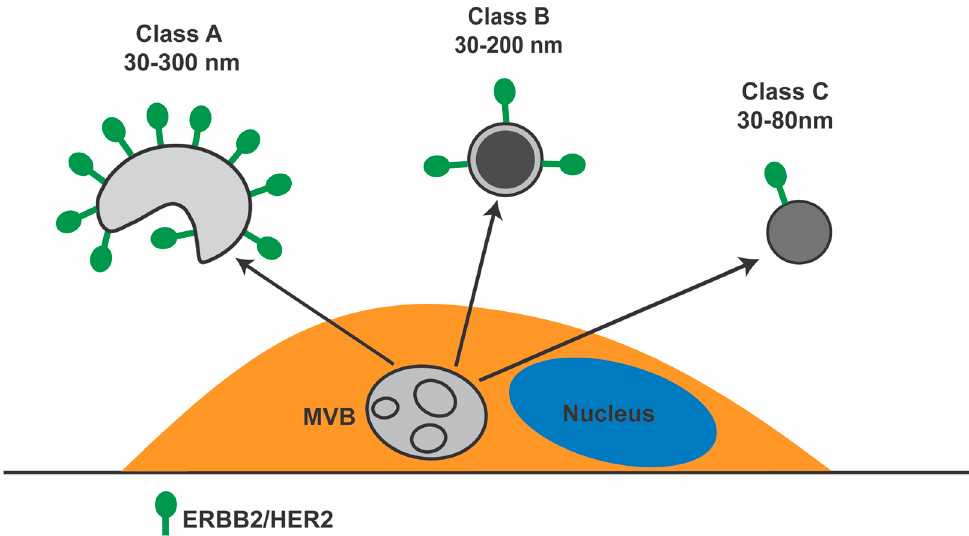
Figure 6. Schematic diagram showing the three main morphological classes of EVs released by SKBR-3 BCa cells. MVB, multivesicular body. ERBB2 on the cell plasma membrane was omitted . Supplementary Materials: The following are available online at www.mdpi.com/xxx/s1, Table S1: Antibodies used in this study, Table S2: Proteins regulated by trastuzumab (Tz) in extracellular ves- icles (EVs) from SKBR3 cell.